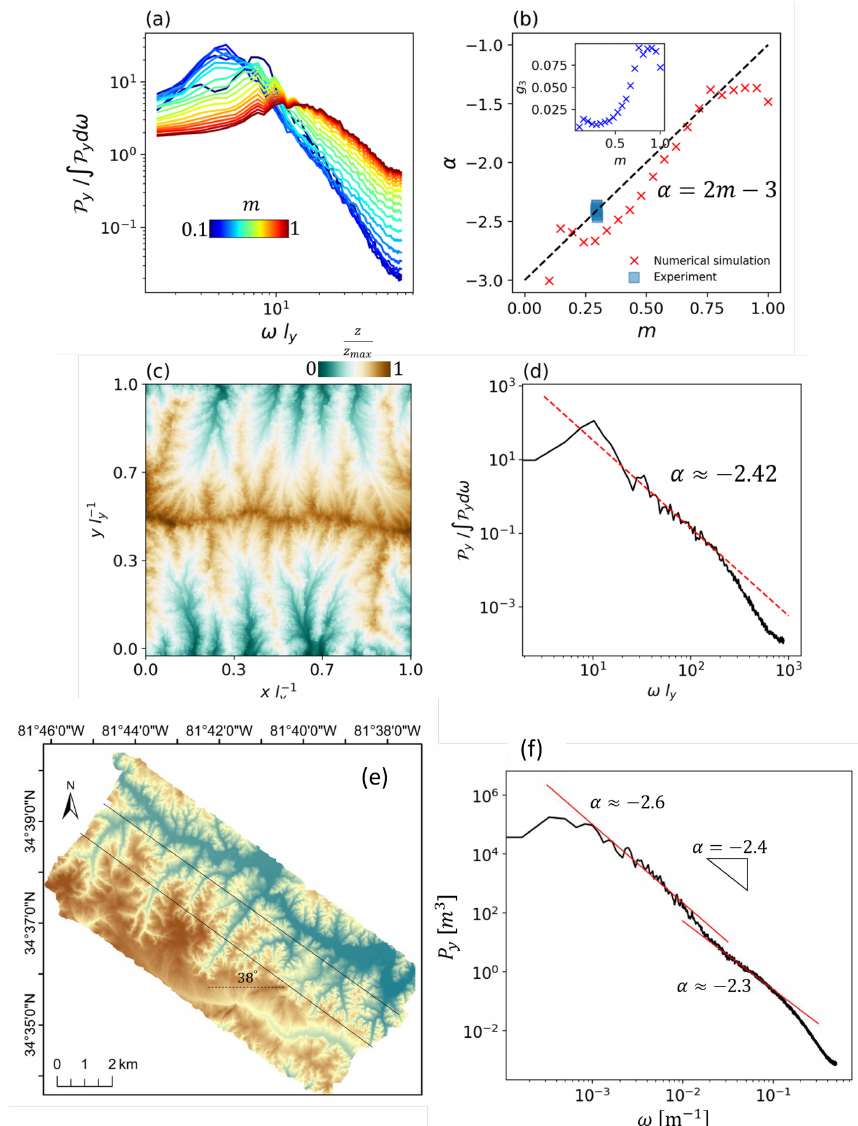
Figure 8. (a) PSDs of elevation longitudinal series for different values of m at an intermediate distance from the boundary. (b) Slope of the power fit to the declining part of the PSD from simulations with C I ≥ 10 5 , denoted by α , as a function of the exponent m . The data from the XLE physical experiment are also shown. The black line is the relation α = 2 m − 3 derived from dimensional and self-similarity arguments in Eq. (43). The inset shows the function g 3 (m) from numerical simulations. Panel (c) shows an example of the XLE experimental landscape (Hooshyar et al., 2019), of which panel (d) shows the PSD. (e) Portion of the landscape at the Calhoun Critical Zone Observatory in South Carolina, USA, from 1m resolution lidar data. (f) The PSD is computed from one-dimensional transects within the area contained by the two parallel lines that are located at an intermediate distance from the main channel showing two distinct power-law scaling regions with similar exponents. After Hooshyar et al.